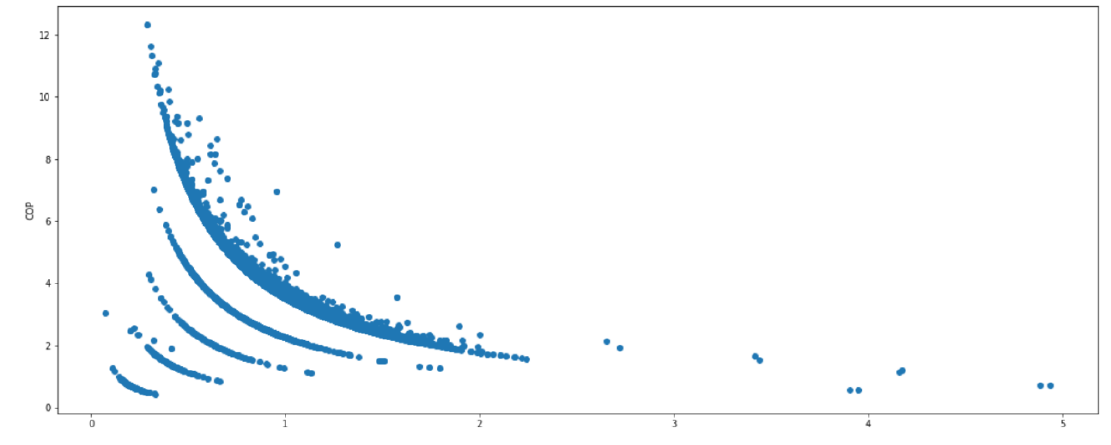
Figure 3. Scatter diagram of the kW/RT and COP.